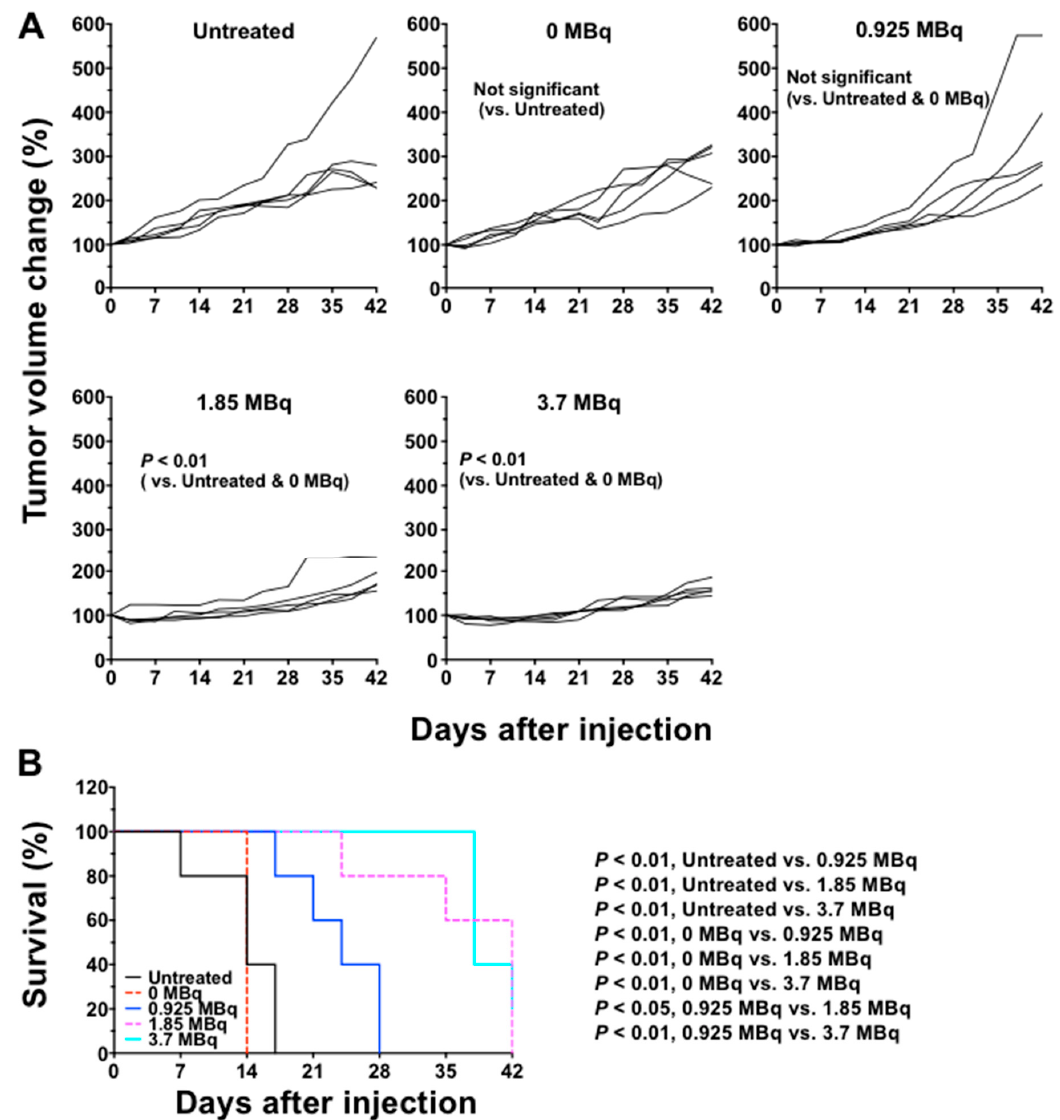
Figure 3. Growth curves of BxPC-3 tumors in mice injected with 90 Y-hs8001 alone. The injected doses were 0 (antibody only), 0.925, 1.85 and 3.7 MBq of 90 Y-hs8001. Tumor size was measured at least twice a week. Data are presented as mean ± SD. Individual animal tumor growth curves ( A ) are shown as well as a survival curve ( B ) based on the endpoint of 150% tumor volume.